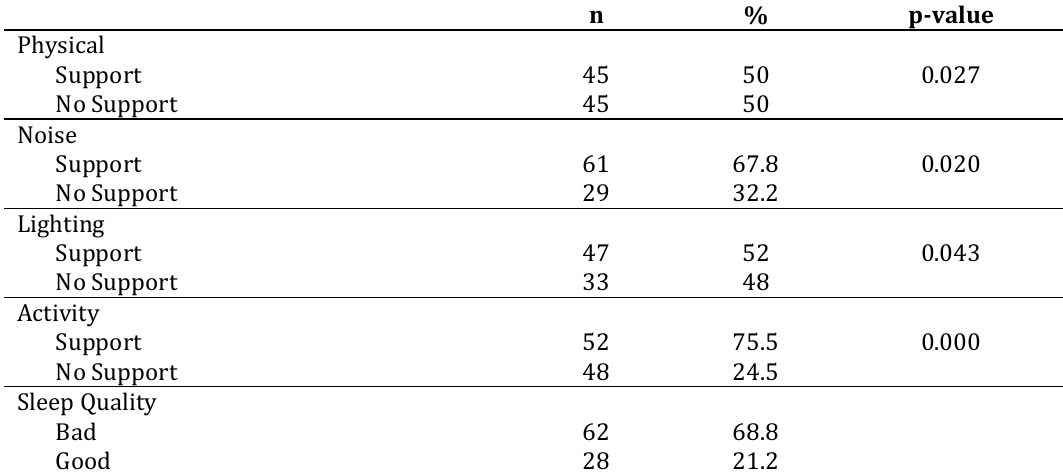
Research Variable and Bivariate Analysis